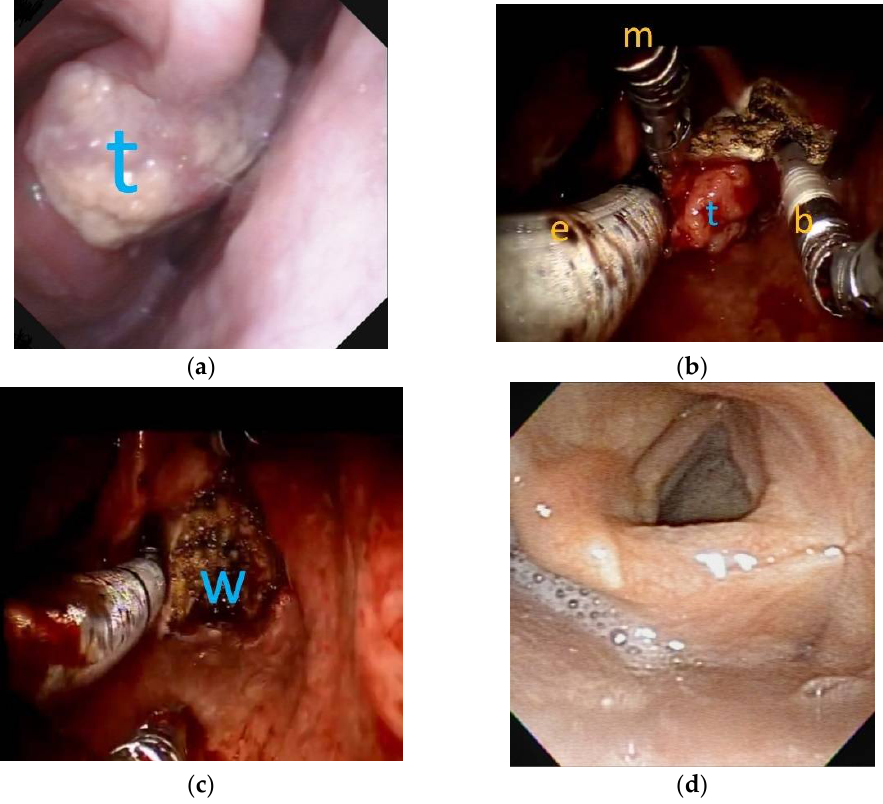
Figure 1. The flexible laryngoscopic view and robotic surgery view of a T2 right side aryteno-epiglottic fold cancer: ( a ) before transoral robotic surgery (TORS), a clinical T2 tumor (t) was located at right-side arytenoepiglottic fold; ( b ) during TORS, under general anesthesia with oroendotracheal tube (e) ventilation, robotic Maryland dissector (m) and monopolar bovie (b) were used to resect the tumor. ( c ) Complete enbloc resection of the tumor was achieved by TORS with surgical wound (w) on the right pyriform sinus. ( d ) Three years after TORS without adjuvant radiotherapy, the pyriform sinus exhibited good appearance without tumor recurrence.